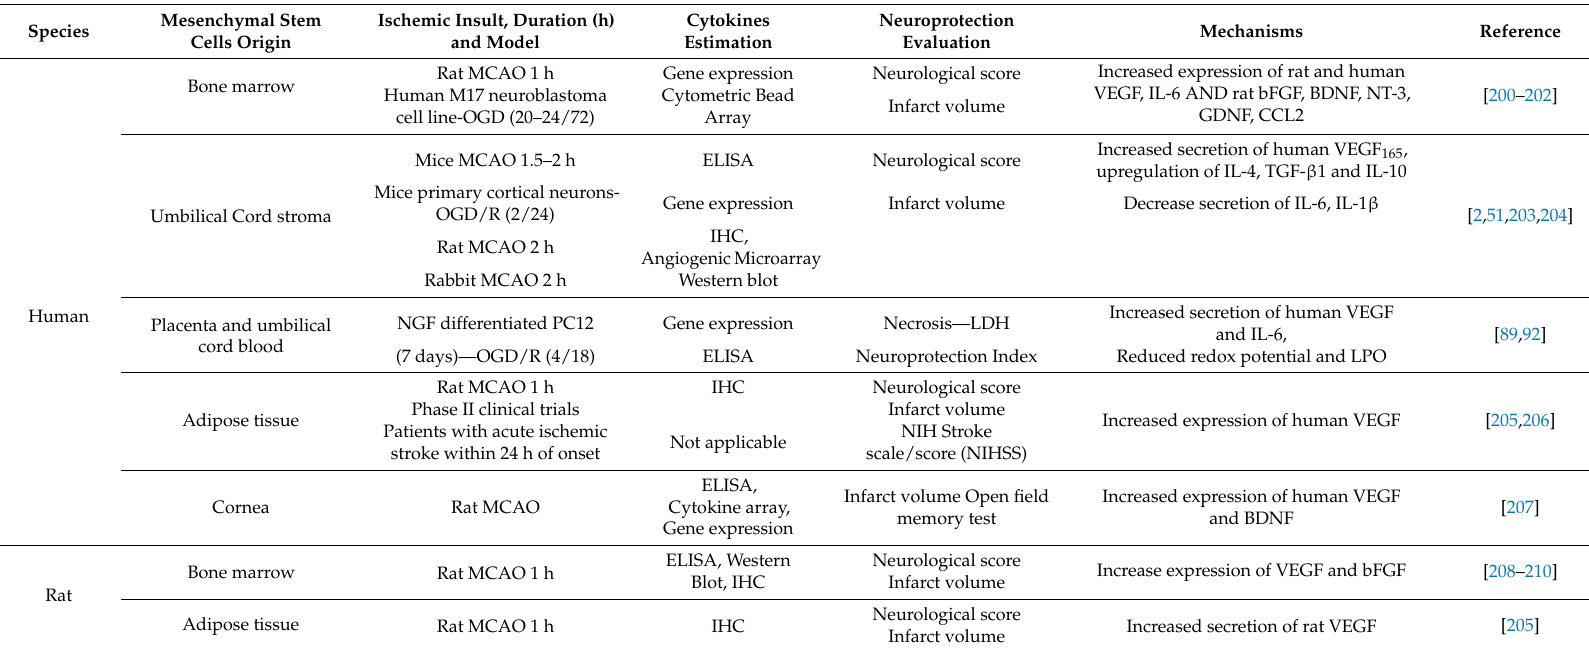
Table 2. Involvement of VEGF and IL-6 in neuroprotective effects of mesenchymal stem